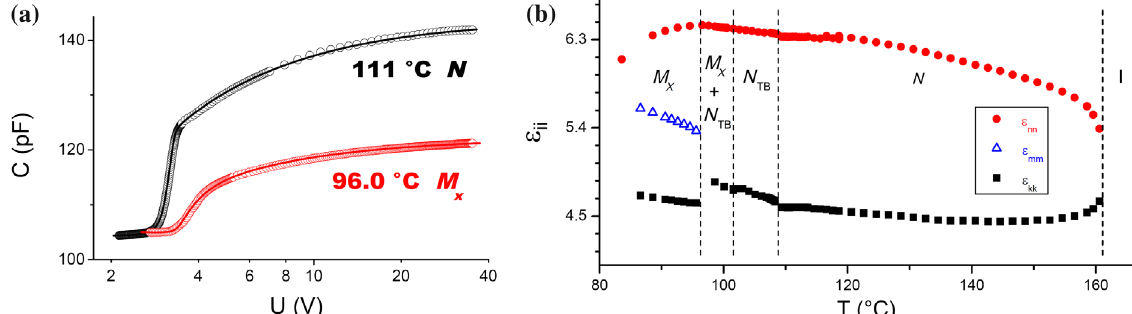
FIG. 8. Dielectric data of the BP12 mixture (cell thickness 9 . 8 μ m). (a) Cell capacitance versus applied voltage in the N phase (black symbols) and in the M phase (red symbols). The solid lines show the best fits of the data with the theoretical model (see Appendix E). X (b) Temperature dependence of the dielectric tensor eigenvalues measured in the uniaxial N and N